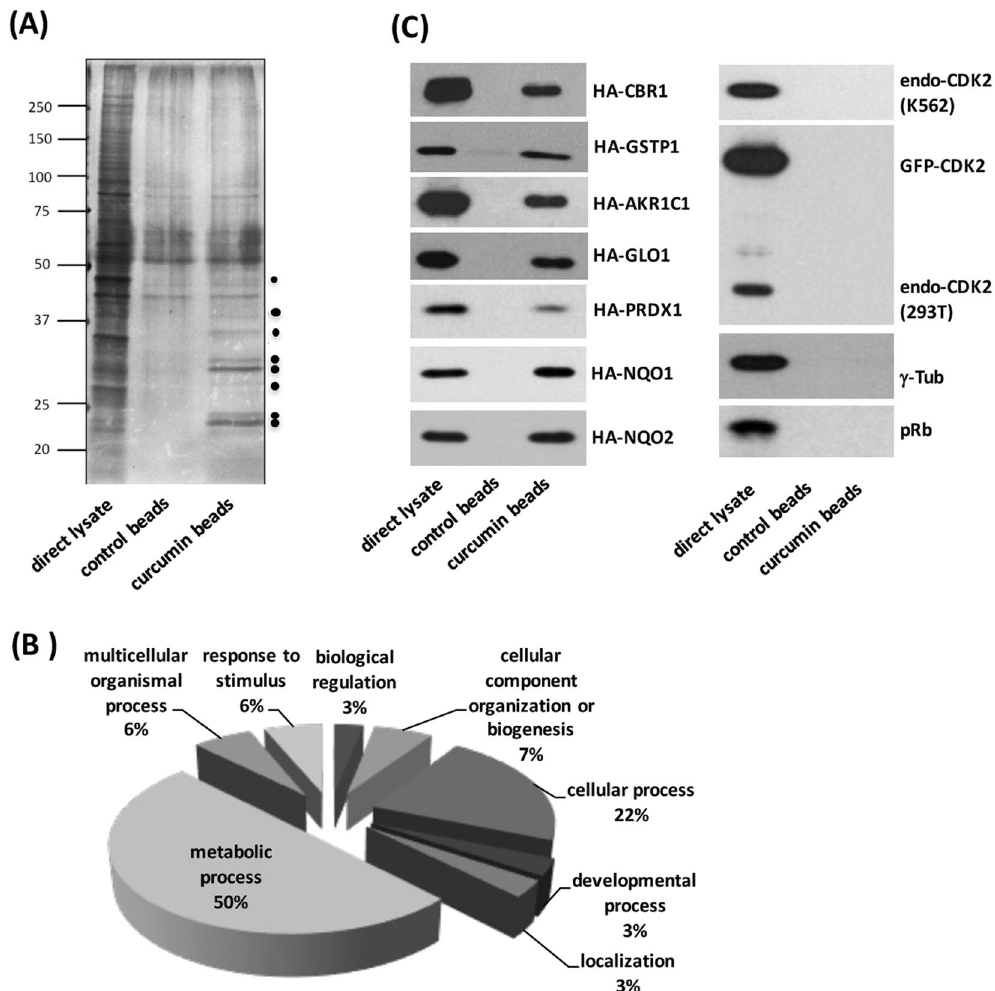
Figure 4. Identification of curcumin-binding proteins in K562 cells. ( A ) The lysate from proliferating K562 cells was incubated with curcumin-sepharose beads (prepared as described in the Materials and Methods). Bound proteins were separated by SDS-PAGE and visualized by silver staining (the bands of putative candidates are marked by the dots). ( B ) Bound proteins were analyzed by MALDI-TOF spectrometry. The list of curcumin- binding proteins (Table 1) was subjected to the PANTHER classification system. ( C ) Lysates isolated from 293 T cells containing HA-CBR1, HA-GSTP1, HA-AKR1C1, HA-GLO1, HA-PRDX1, HA-NQO1, and HA- NQO2 proteins were subjected to the pull-down assay using curcumin beads. Bound proteins were detected by immunoblotting using an anti-HA antibody. Endogenous CDK2, GFP-fused ectopic CDK2, γ -tubulin, and retinoblastoma protein (pRb) were used as negative